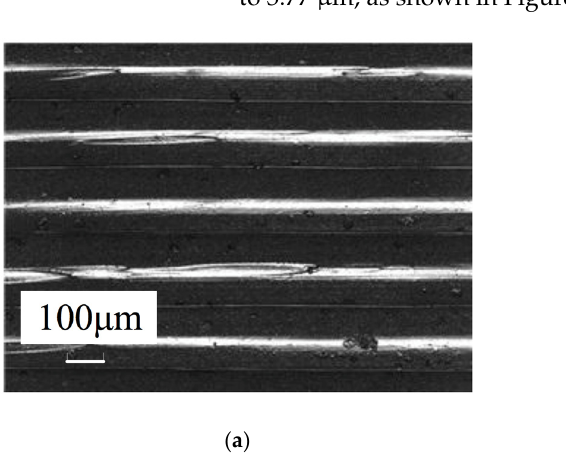
Figure 12. PLA parts and roughness: ( a ) before chemical vapor finishing and ( b ) after chemical vapor finishing of the surface [24].